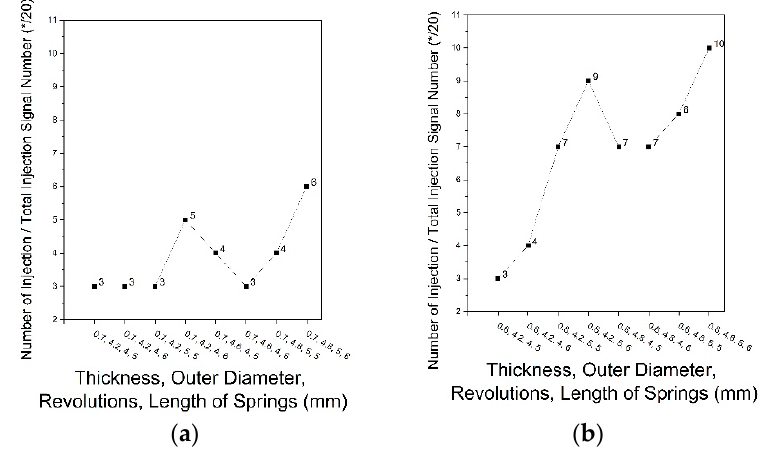
Figure 7. Actual number of injections according to the thickness of the steel wire; ( a ) 0.7 mm, ( b ) 0.8 mm.